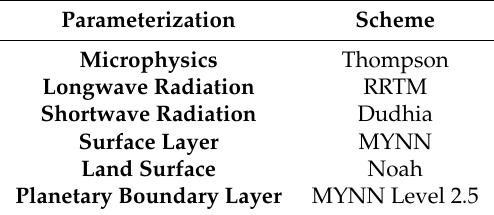
Figure 3. Domains used in the present study. The single-nest ensemble uses the 3-km domain; the double-nest ensemble nests the 1-km domain inside the 3-km domain. Table 1. Parameterization schemes used in the numerical modeling